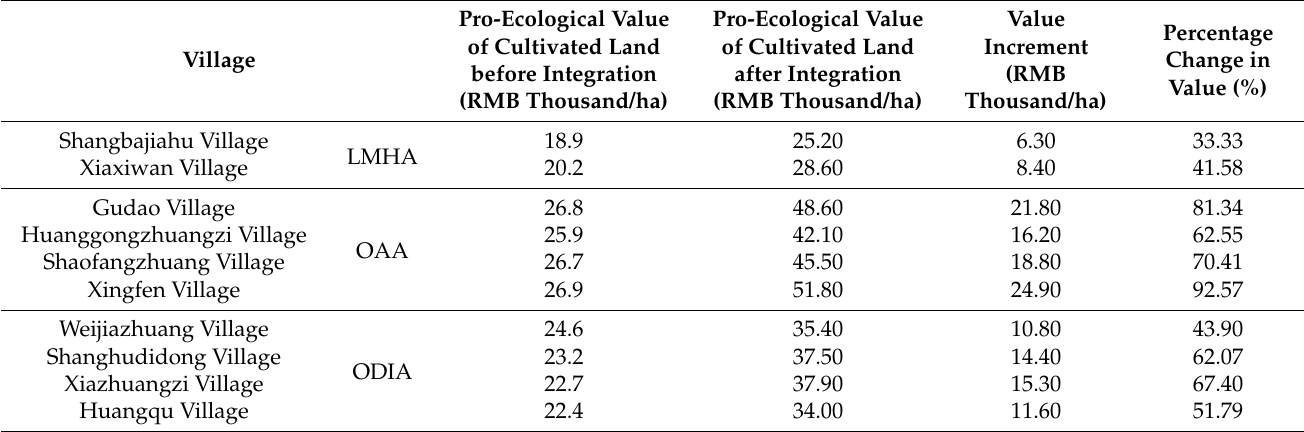
Table 5. Pro-ecological value of cultivated land before and after